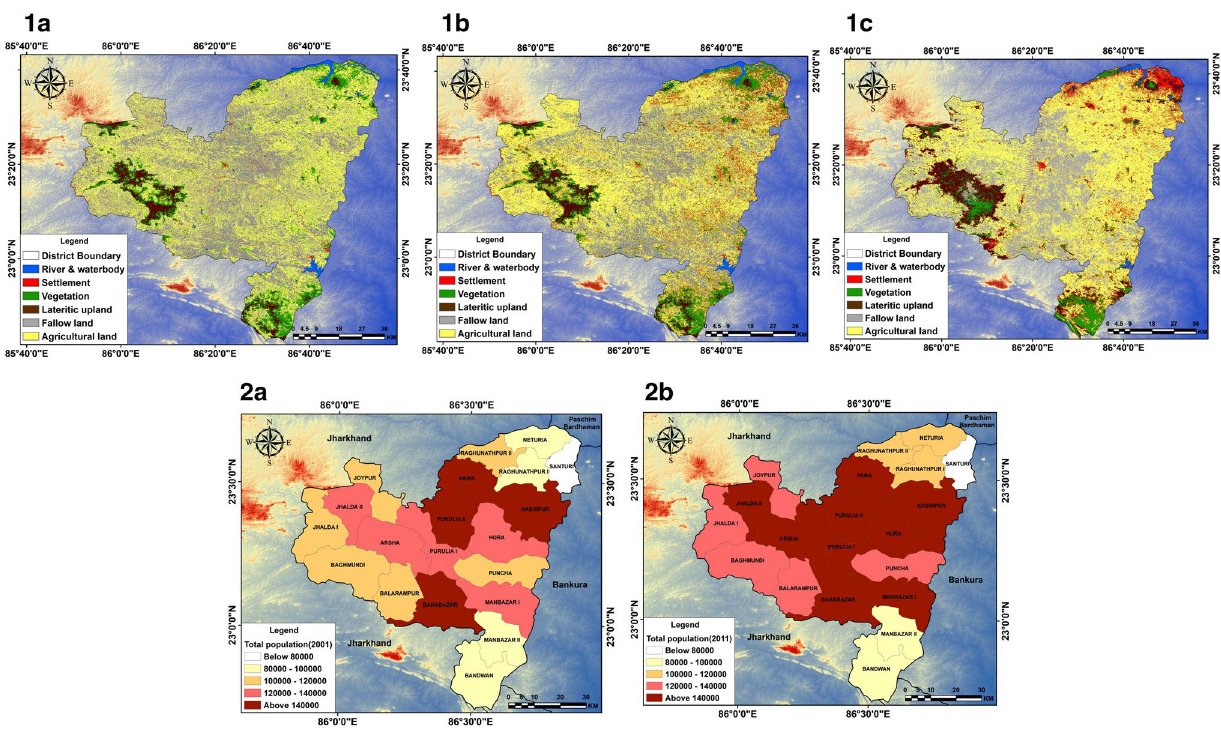
Fig. 5 LULC maps of different years, 1a 2000, 1b 2010 and 1c 2020. Choropleth maps showing the population density of Purulia district of dif- ferent years, 2a 2001 2b 2011 Fig. 6 Bar graph showing the month wise distributional pattern of rainfall at Purulia district in a time frame of 1996–2020. Here the dotted red line indicates the general trend of rainfall in the restricted